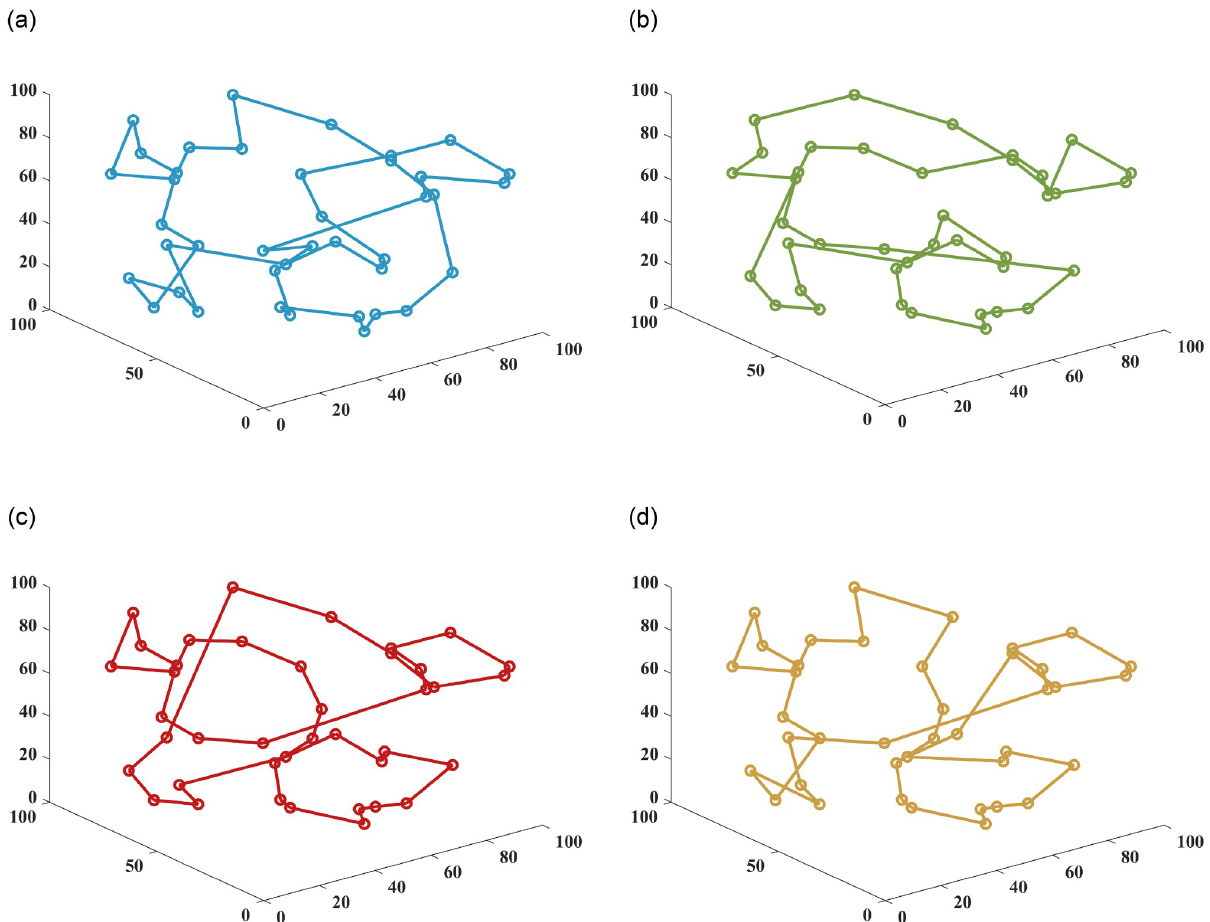
Fig 6. Picked roadmap obtained by four algorithms under 40 fruits. (a) ACO Picking Path. (b) ASrank Picking Path. (c) IACO Picking Path. (d) OSACO Picking Path.